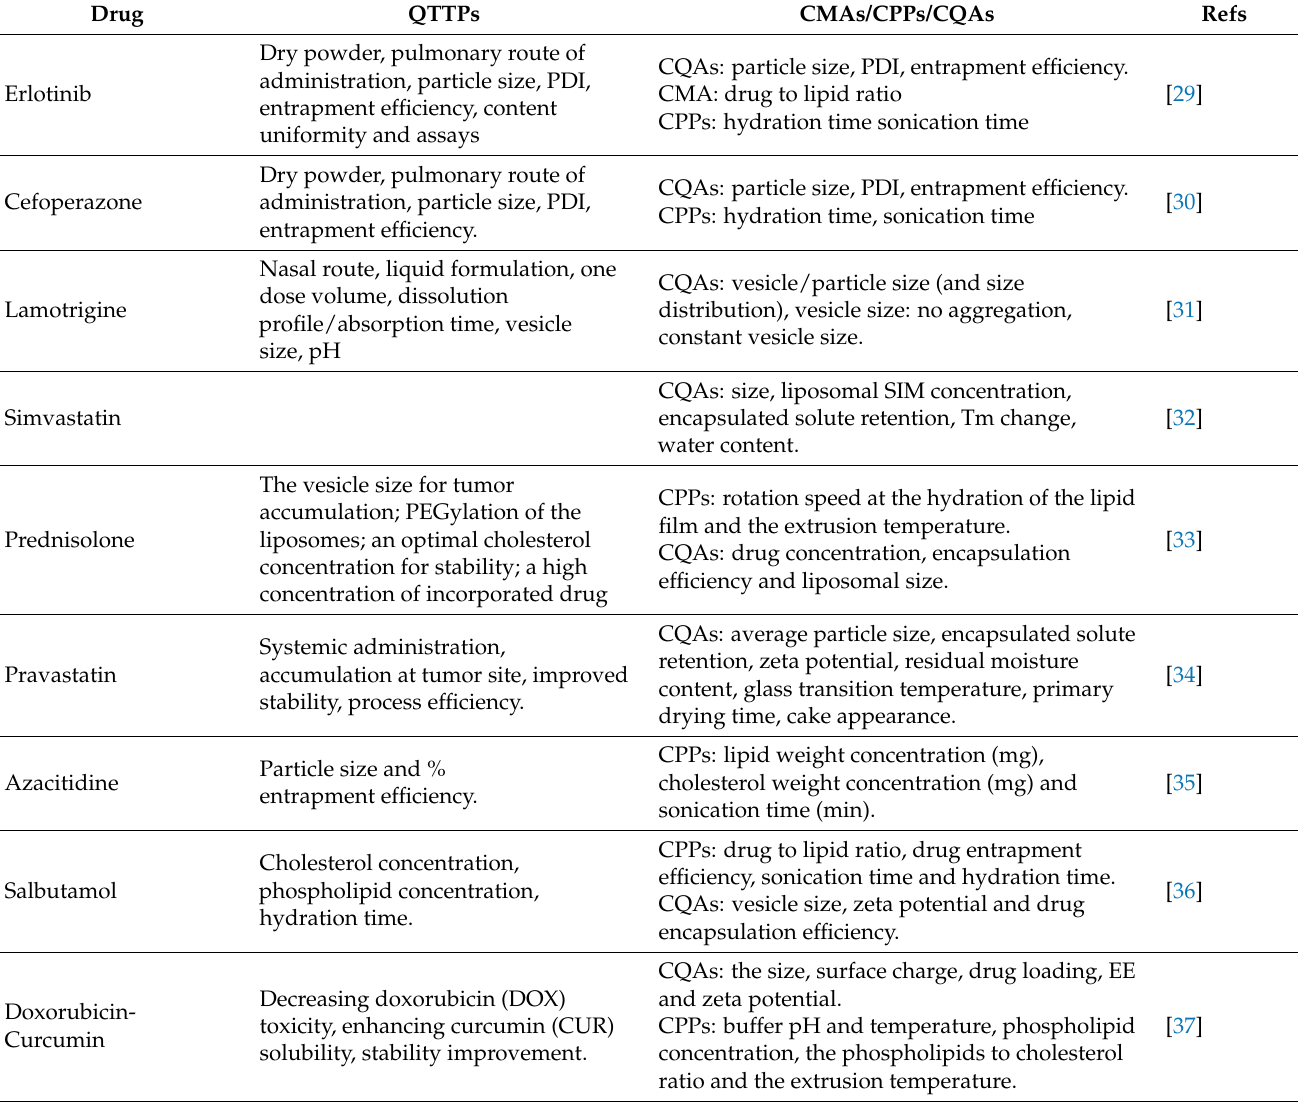
Table 1. Examples of pharmaceutical liposomes developed by